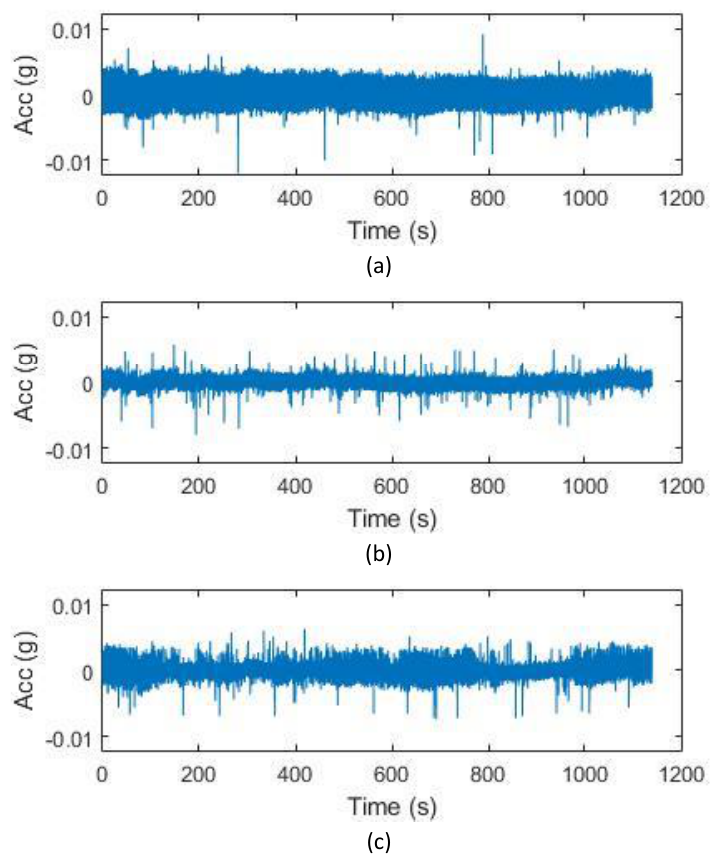
Figure 9. Acceleration response of the structure measured by Sensor “B” for the second measurement (M2). ( a ) Channel X. ( b ) Channel Y. ( c ) Channel Z.